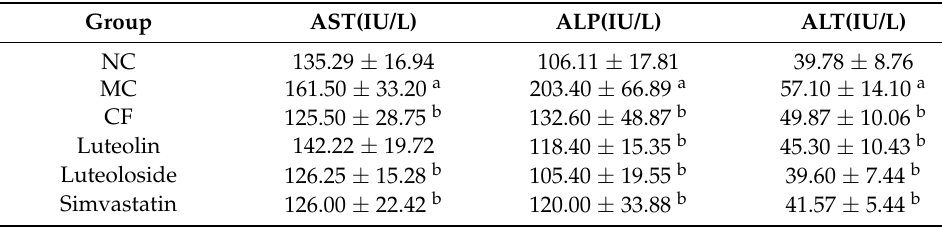
Table 8. Changes of AST, ALT, and ALP in the serum of each group.